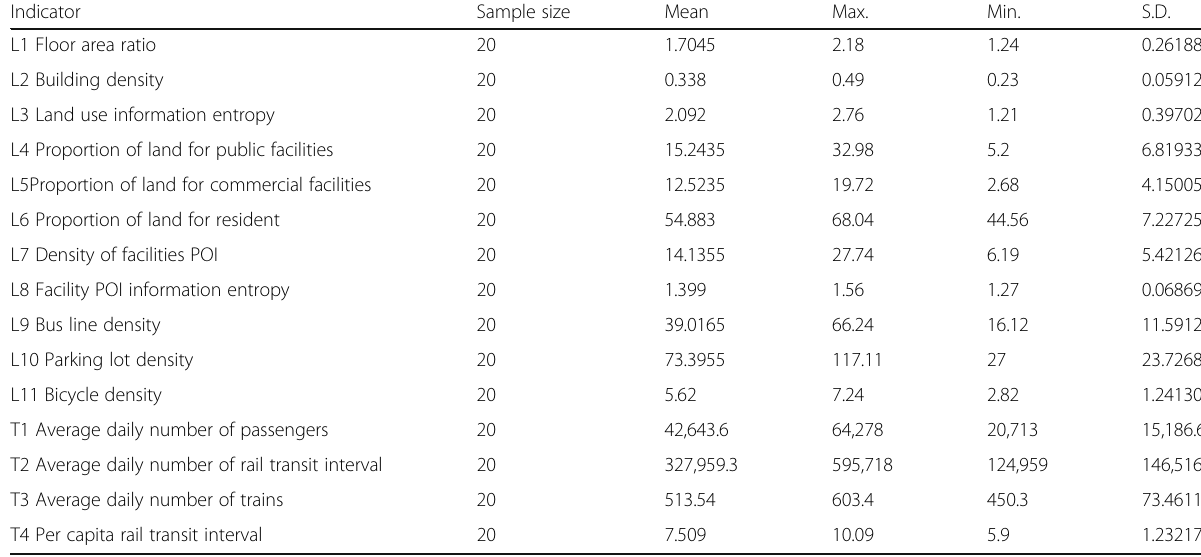
Table 5 Summary of data collection